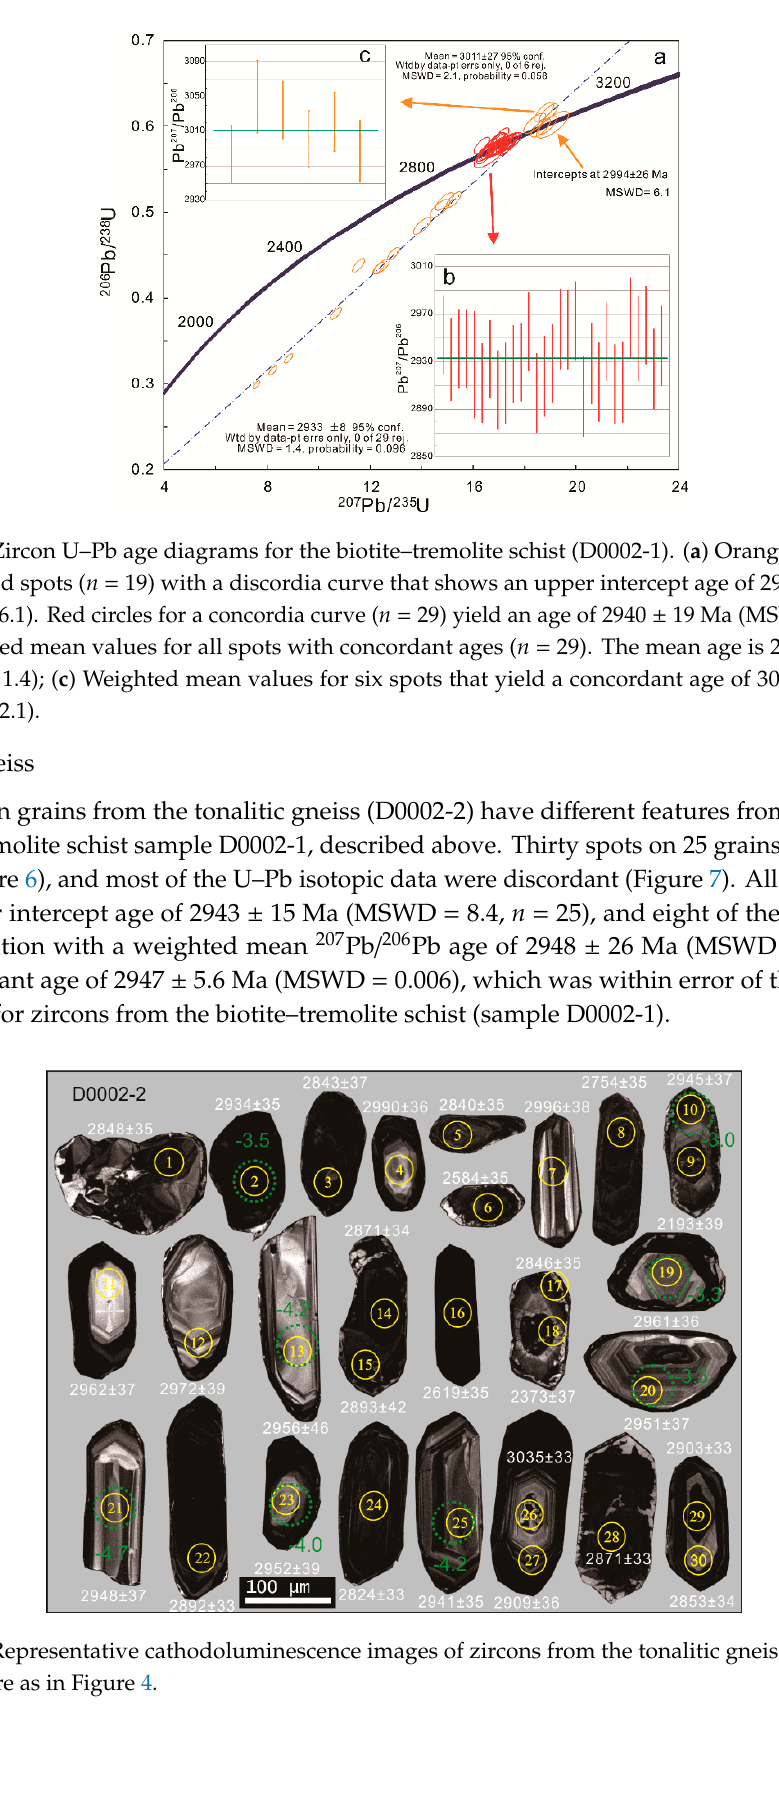
Figure 7. Zircon U–Pb concordia age diagram for the tonalitic gneiss (D0002-2). ( a ) Diagram for all analytical spots that gave a discordia line with an upper intercept 207 Pb/ 206 Pb age of 2943 ± 15 Ma; ( b , c )